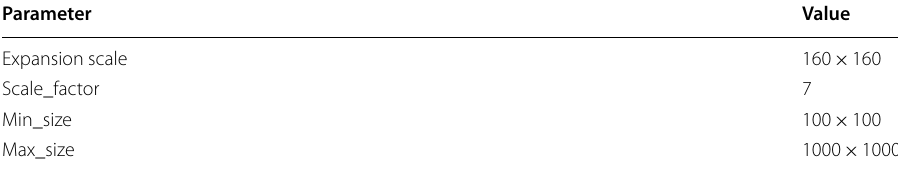
Table 2 Parameters of CascadeClassifier